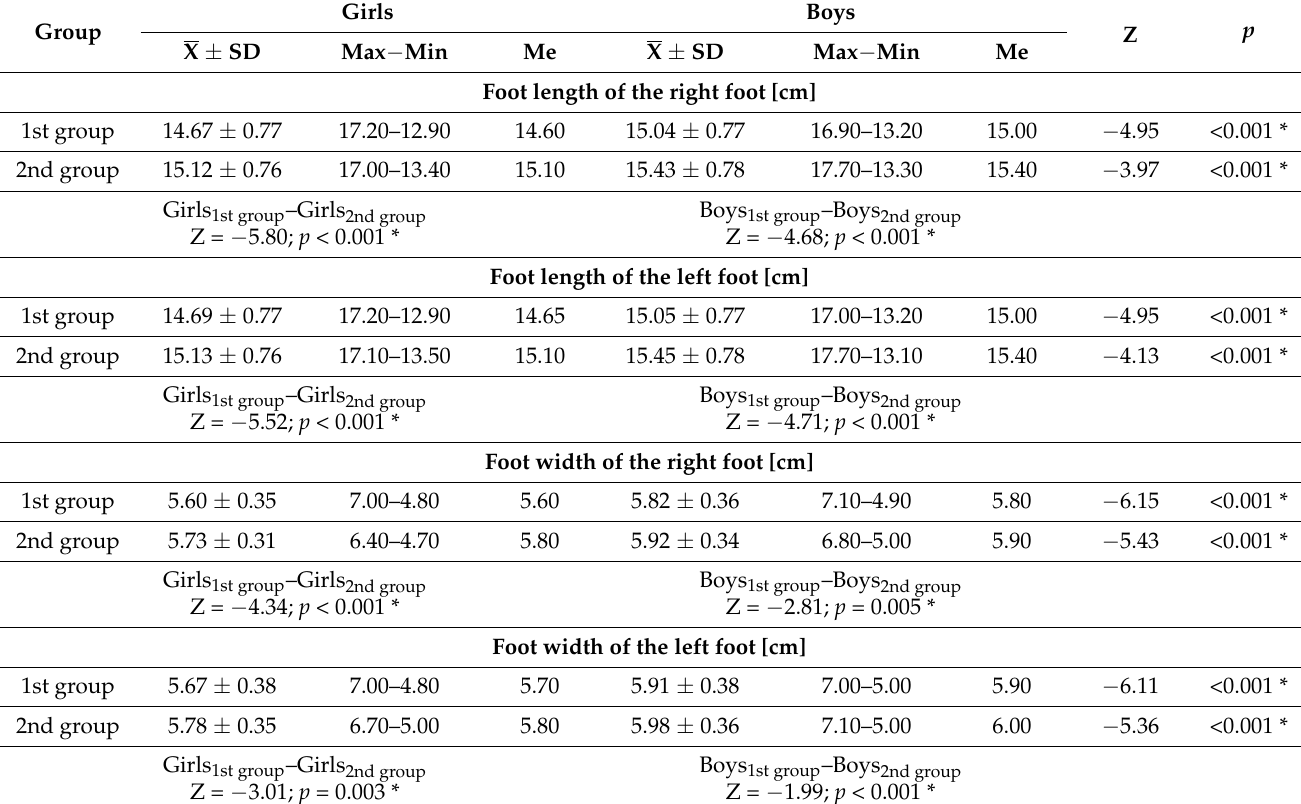
Table 3. The comparison of the length and width of the feet of 3-year-old girls and boys, taking into account half-yearly age